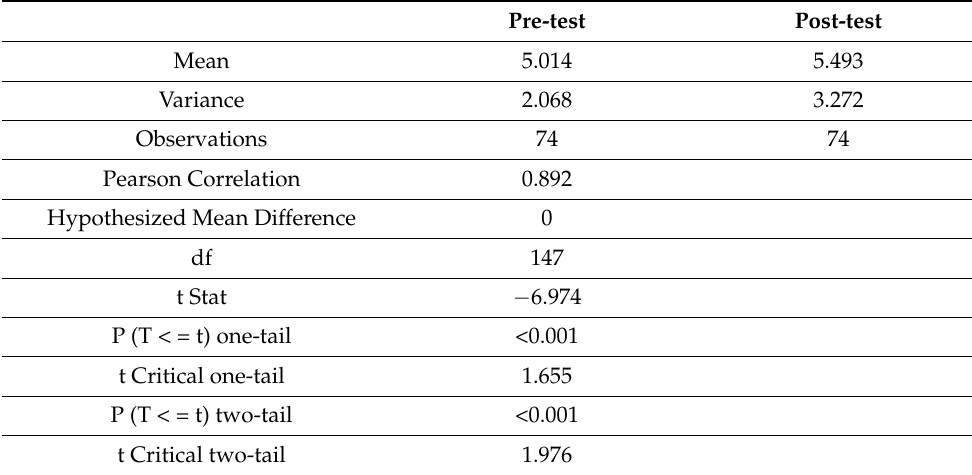
Table 9. t -test: Paired two samples for means of group